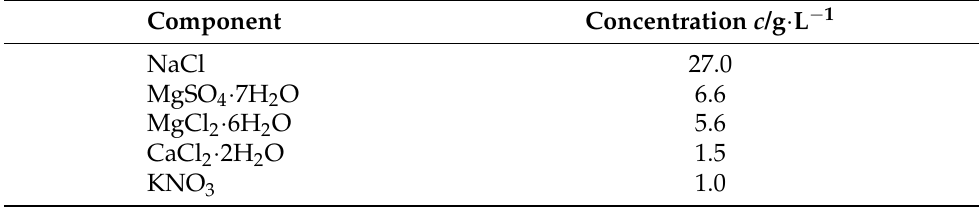
Table 2. Composition of the